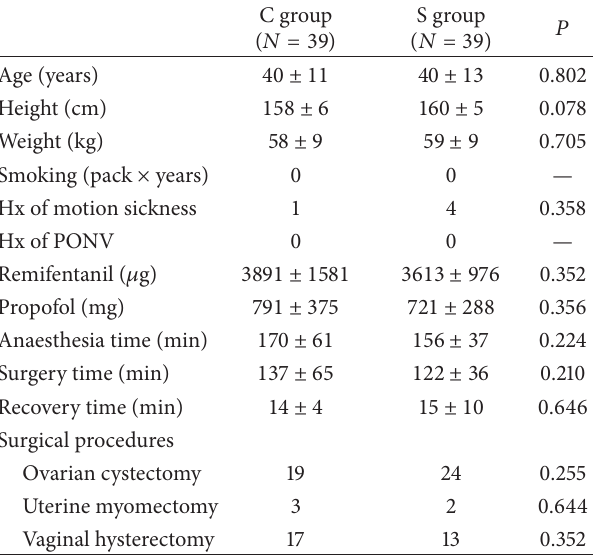
Table 1: Patient demographics.